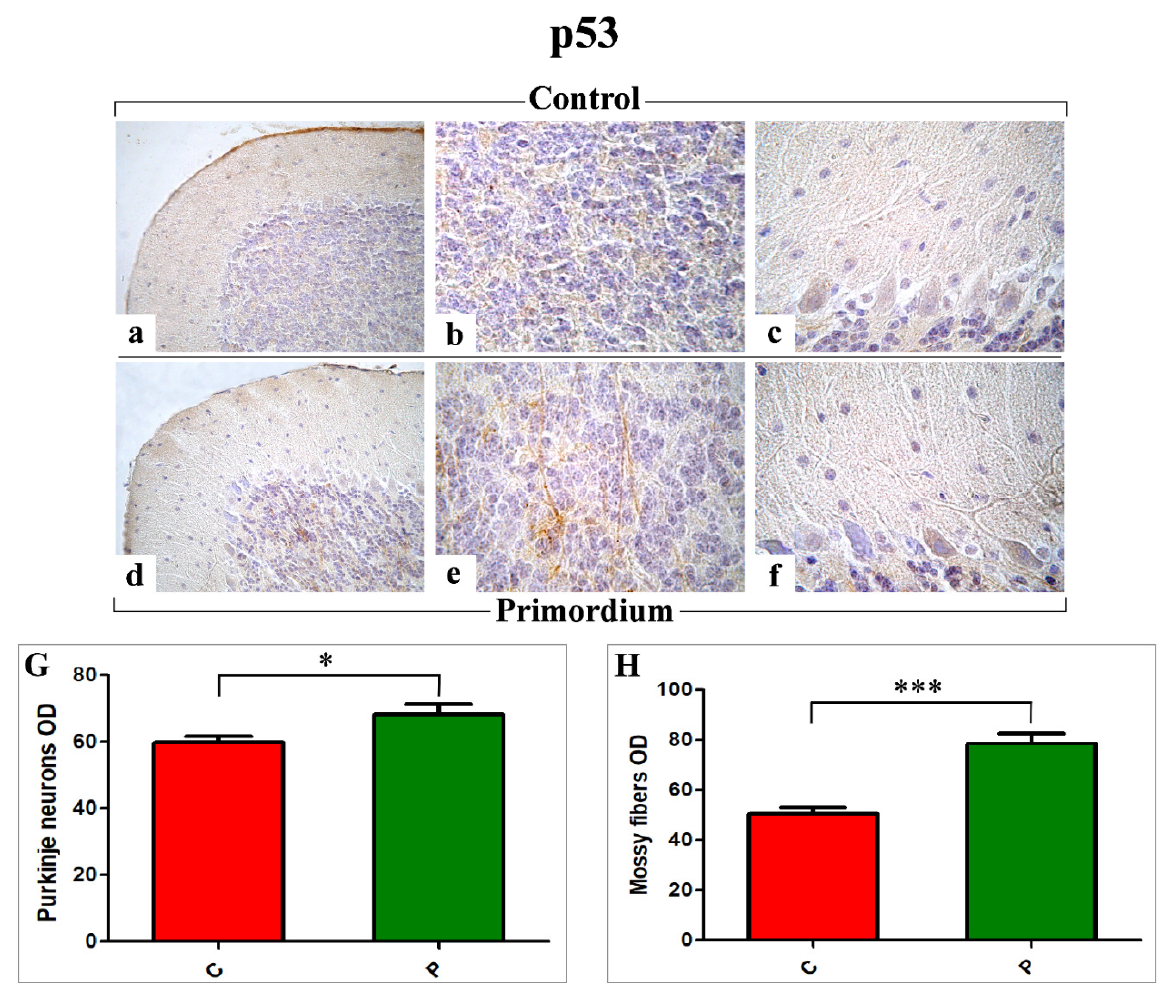
Figure 6. Immunohistochemical labelling for p53 in C ( a – c ) and P ( d – f ) mice. Panels G and H: Histograms showing the quantitative analysis of p53 immunopositive PCs and mossy fibers OD (( G , H ), respectively). p values, calculated by unpaired t -test, were considered significant for p < 0.05 (*) and p < 0.001 (***).